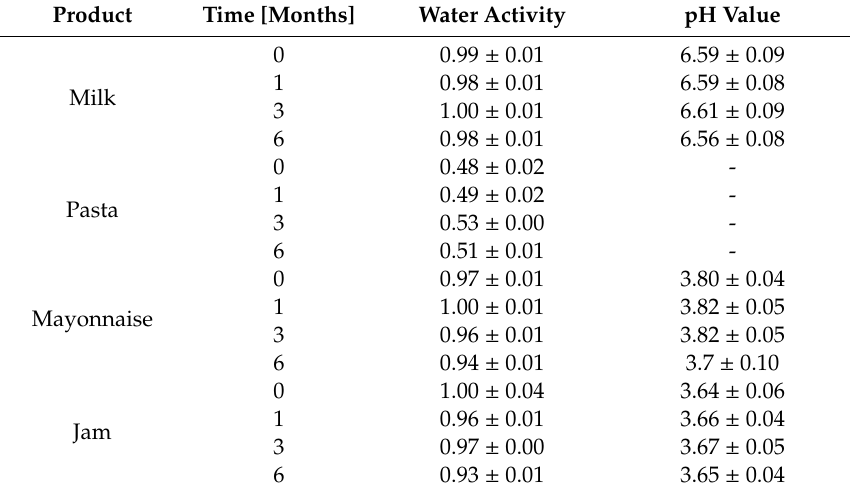
Table 6. Physico–chemical analysis of foods tested during